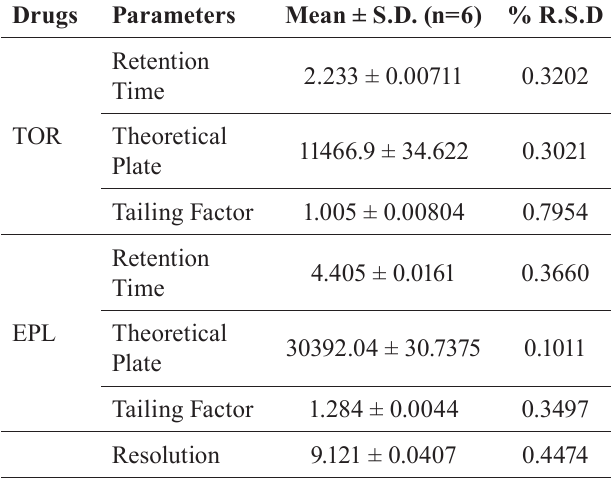
TABLE III - System suitability parameters